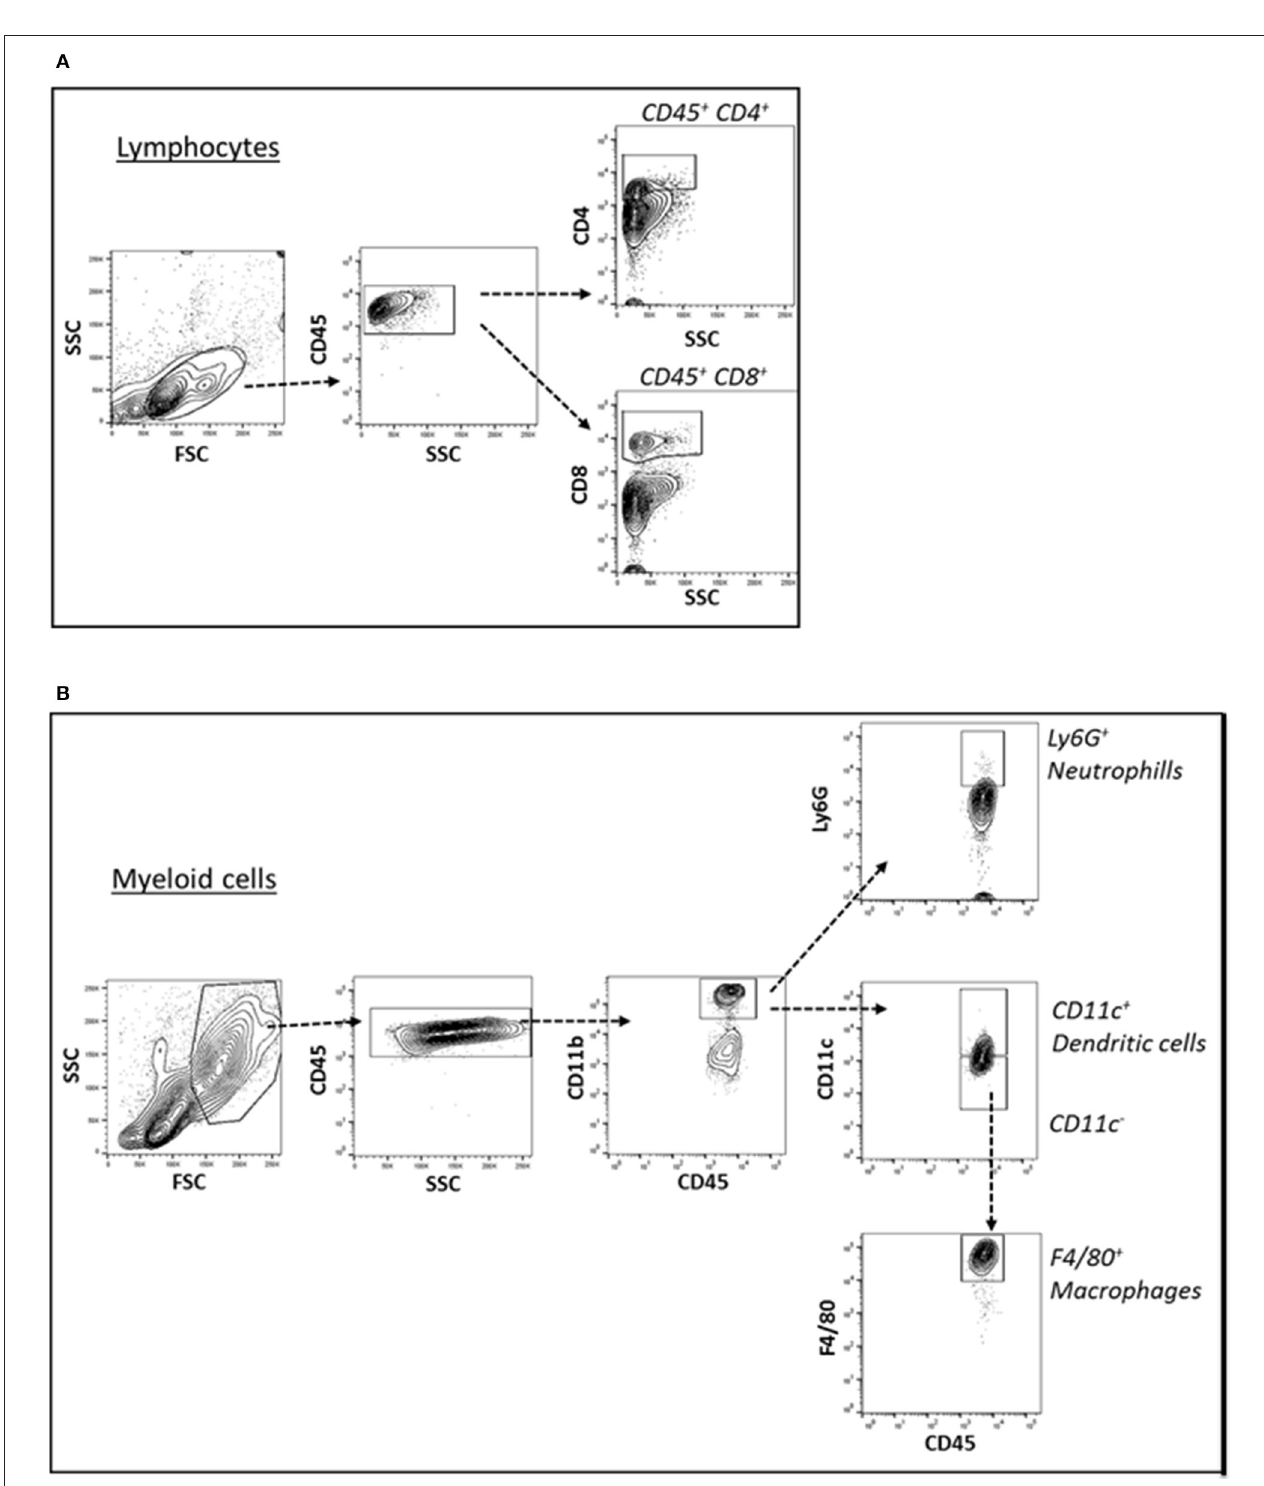
FIGURE 3 | (A) Cell suspension obtained from tissues were surface-stained for T lymphocyte markers with antibody combination CD45, CD4, and CD8 (A) and gated for CD45 + CD4 + T lymphocytes and CD45 + CD8 + T lymphocytes. (B) For myeloid cell subsets, the cell suspensions were surface-stained with antibody against CD45, CD11b, CD11c, Ly6G, and F4/80 (B) and gated for CD45 + CD11b + Ly6G + neutrophils, CD45 + CD11b + CD11c + dendritic cells, CD45 + CD11b + CD11c- F4/80 + macrophages.